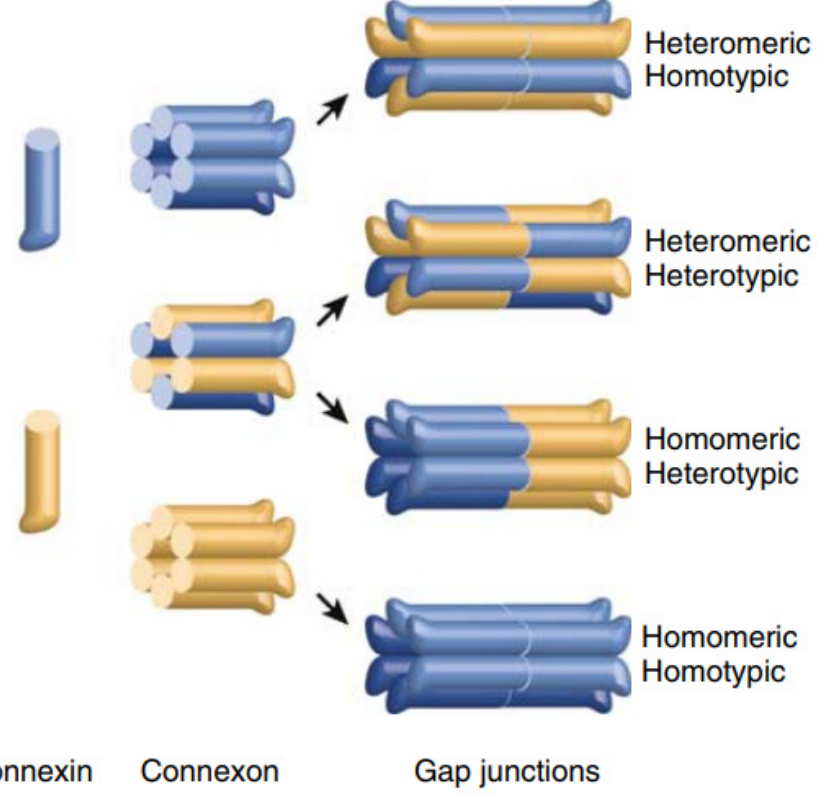
Figure 4. Illustration of connexin interactions resulting in heteromeric and heterotypic channels. When more than one connexin is expressed in a cell the connexins may oligomerize to form a heteromeric connexon. If the connexon functions as a transmembrane channel, as occurs in a small number of cases it is referred to as hemichannel. It is generally assumed that connexins from the same group are capable of forming heteromeric channels although very little information is available about this process. When connexons from different cells interact there is an almost limitless number of possible gap junction channel compositions the simplest being homomeric homotypic (bottom right) and the most complex being heteromeric heterotypic (top right). Most structural and functional analyses have focused on homomeric and homotypic channels. Image modified from [57].